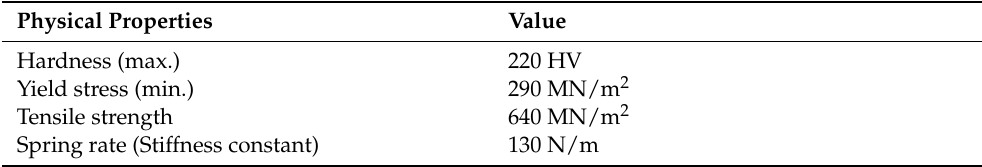
Table 2. Specifications of the SMC.